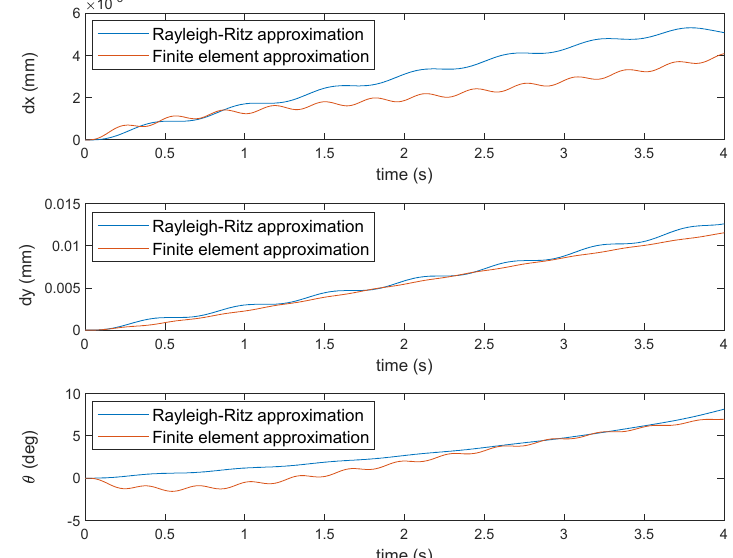
Figure 10. The elastic displacements and the orientation of the end-effector obtained by using the two methods in the case of sinusoidal loads.